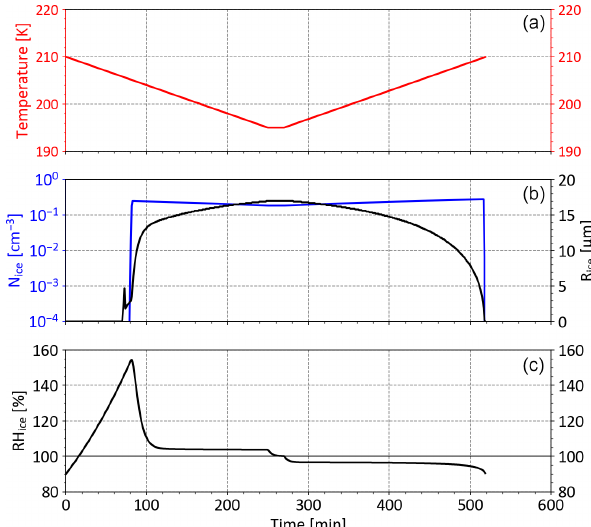
Figure 9. Simulated evolution of cirrus cloud particles initialized at 210K and 90% RH ice as a function of the simulation time in minutes. (a) Temperature of air parcels (unit: K). (b) Ice particle number concentration N ice (cm − 3 , blue) and mass radius mean R ice (µm, black) of cirrus crystals. (c) Relative humidity with respect to ice RH ice (%).